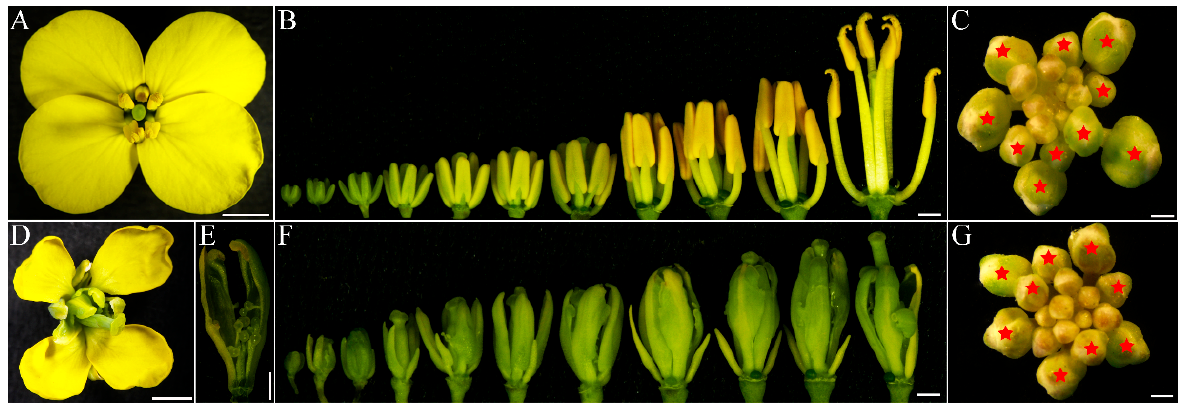
Figure 1. Flower morphology of inap CMS ( D – G ) and its maintainer “H3” ( A – C ) in B. napus . ( A , D ) Flowers; ( B , F ) Floral buds without sepals and petals. ( E ) Carpelloid stamen of inap CMS. ( C , G ) Flower buds at the stages 0–8. Red asterisks mark stage 6–8 buds. Bars: 1 mm.